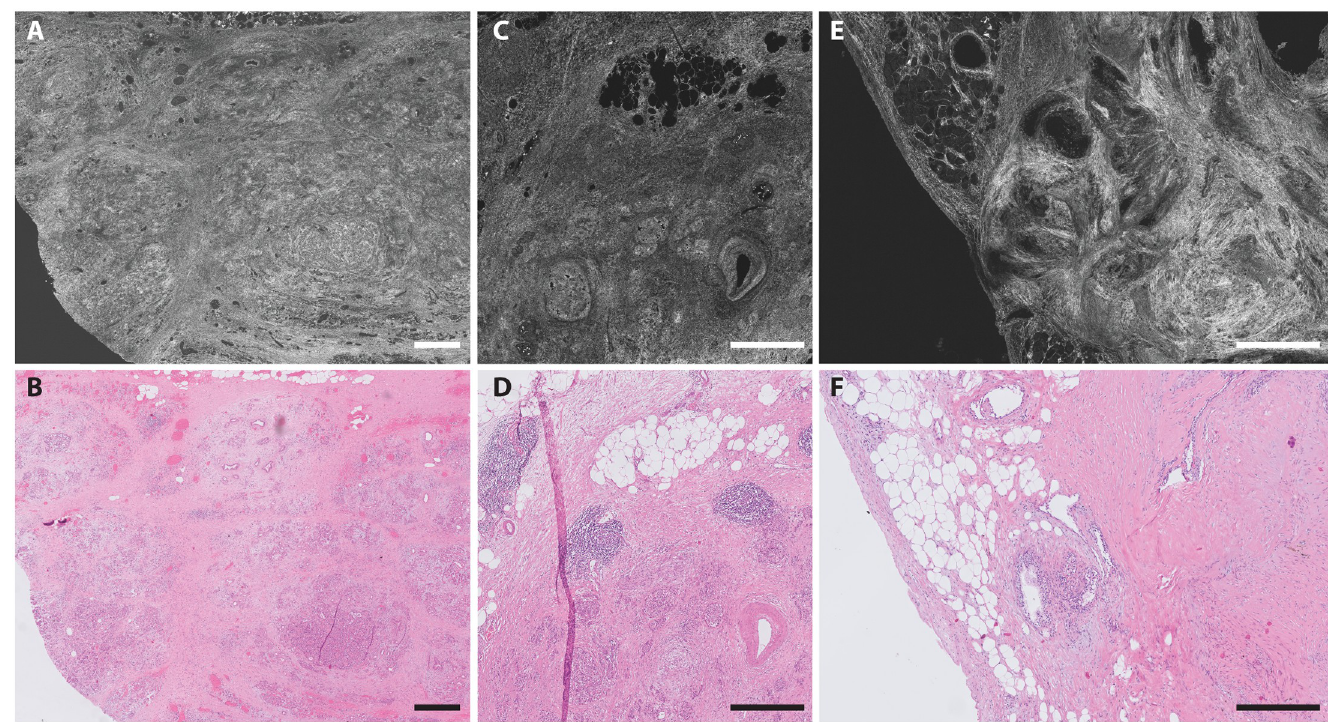
Fig 3. Example of benign pancreatic tissue FF-OCT images and corresponding histology. Fibrotic pancreatic tissue after neoadjuvant therapy (A-B), pancreatitis(C-D), and a serous cystadenoma (E-F). Scale bars all 500 μ m.